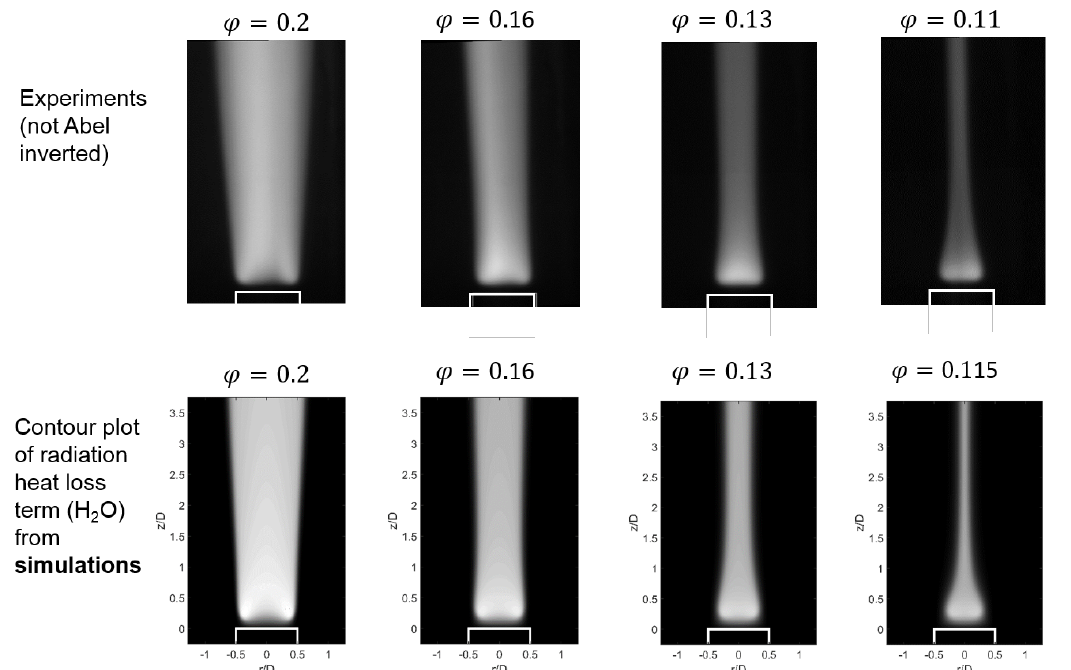
Figure 2. Radiation intensity from burnt gas from experiments ( top row ) and heat loss due to radiation q rad from simulations ( bottom row ) for pre-extinction